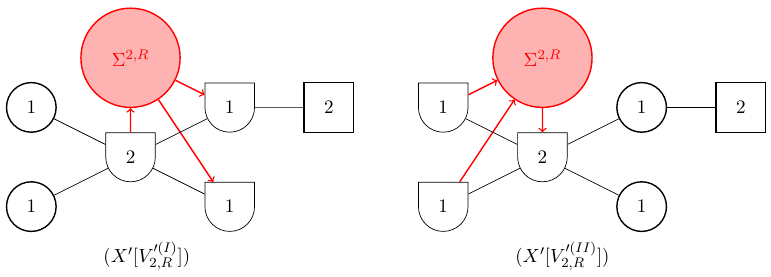
Figure 64 . Two different realizations of a vortex defect for the central U(2) gauge node in the quiver X 0